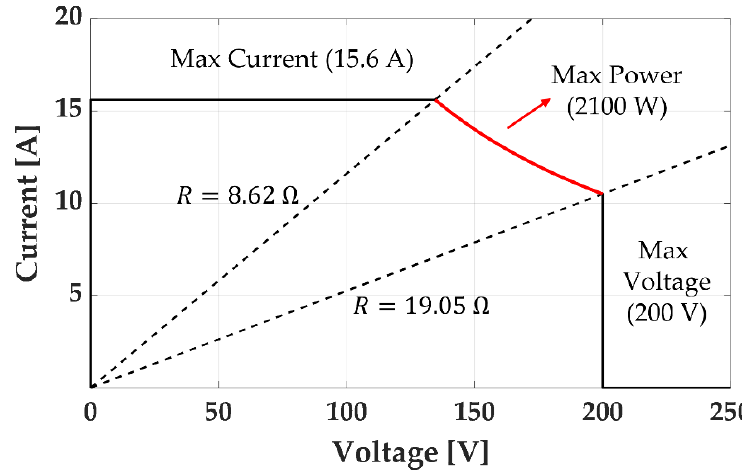
Figure 4. Output range of the power supply unit (3001iX by California Instruments).